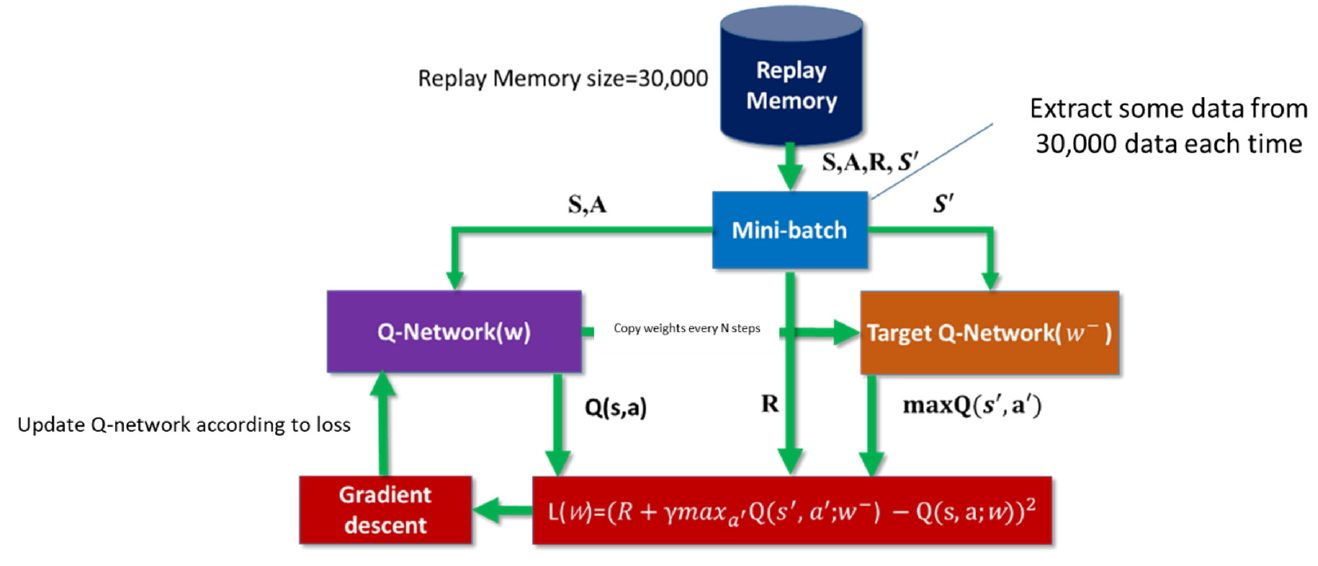
Figure 13. Mini-batch size.